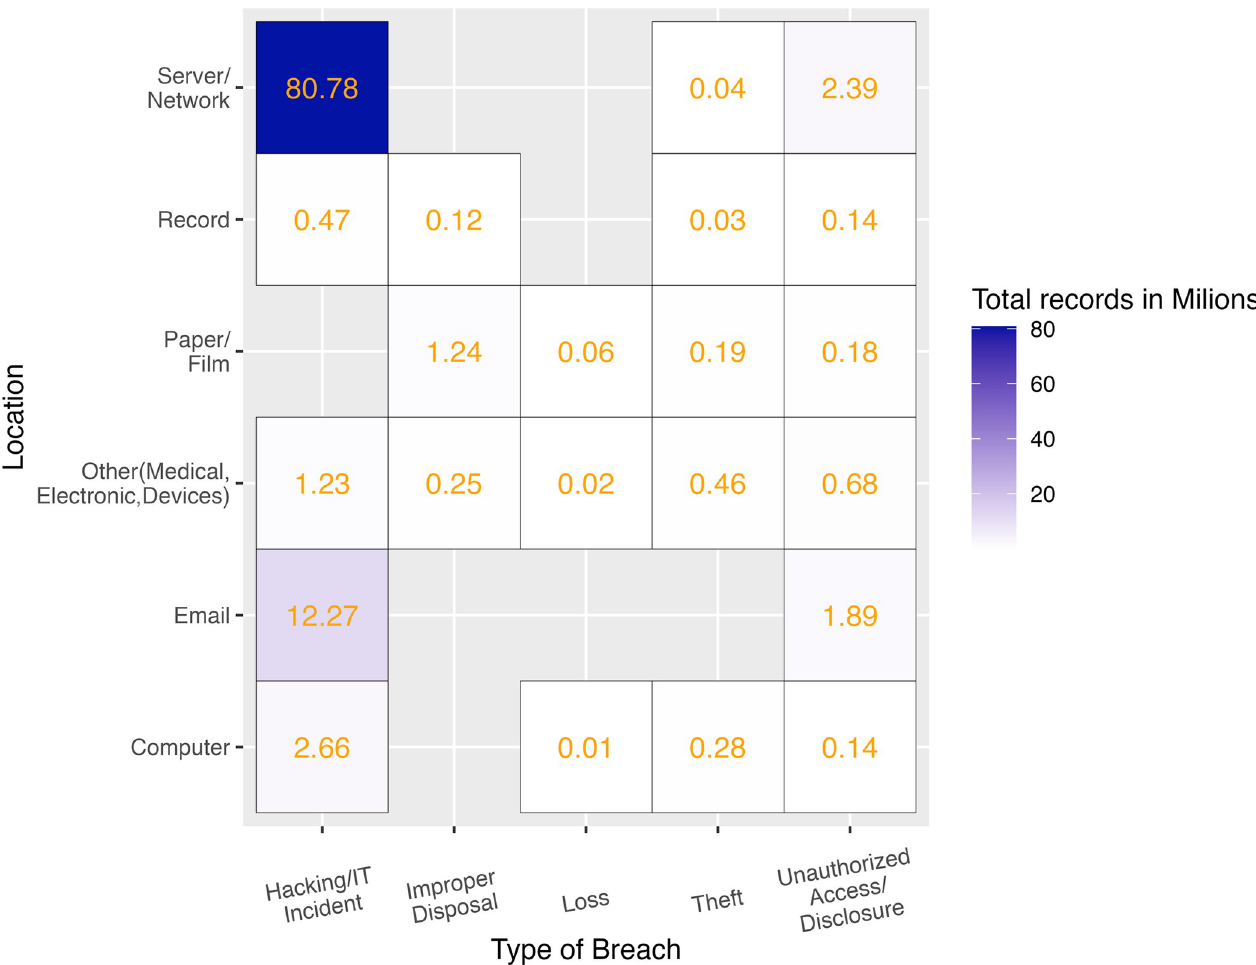
Fig 2. Magnitude of data breaches considering total number of records affected by type of breach and location in the US between November 2019 and November 2021. Elaborated from raw data [32].